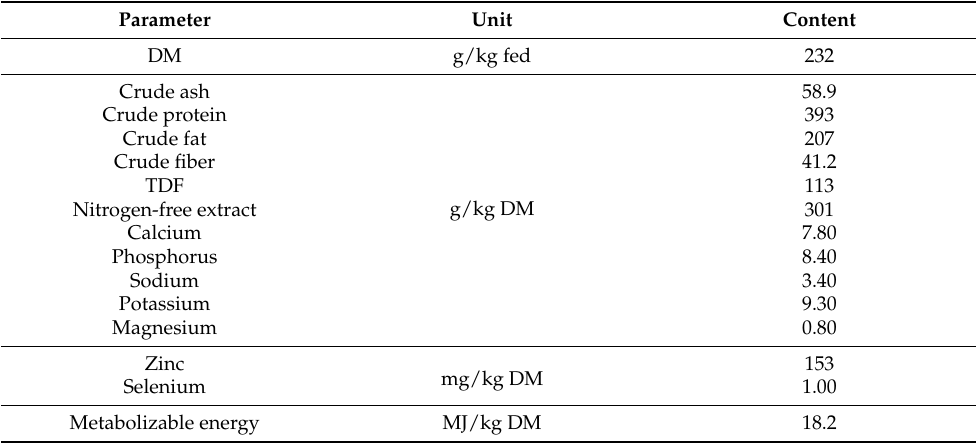
Table 1. Chemical composition of the basic diet fed to Beagle dogs (g/kg DM).